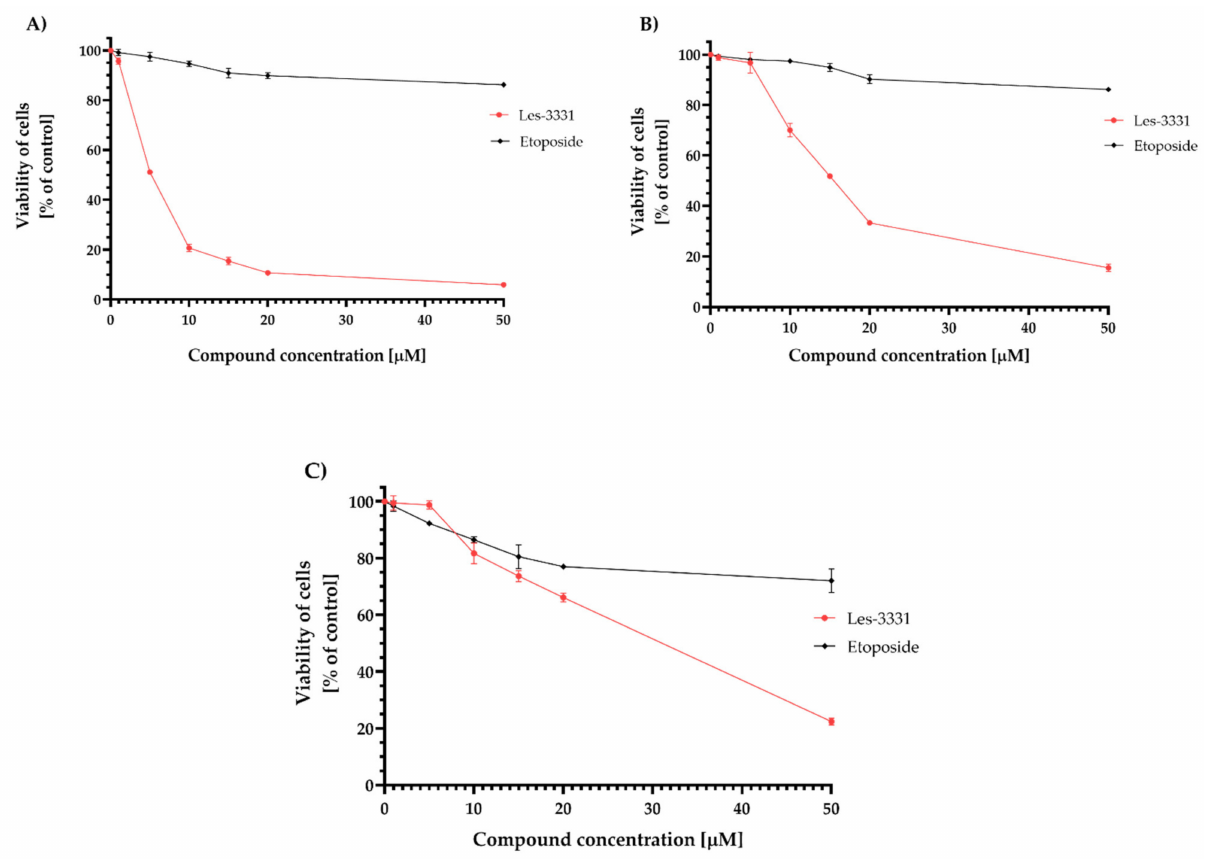
Figure 2. Viability of MCF-7 ( A ), MDA-MB-231 ( B ), and human skin fibroblasts ( C ) incubated for 24 h with Les-3331 and a reference drug (etoposide). Mean ± SD from three independent experiments performed in duplicate is presented.